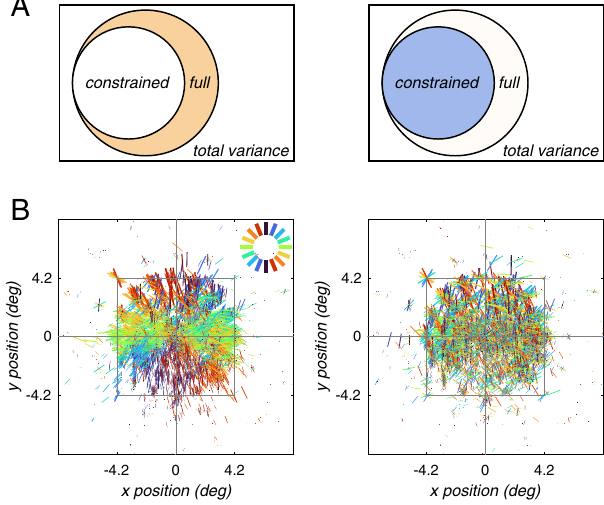
Fig. 6 | Control analyses demonstrate that the full model indeed captures orientation selectivity that cannot be derived from the constrained model. A Schematic Venn diagram illustrating the control analyses. First, the constrained model was fi t. The full model was then fi t either to the residual (left) or the output (right) of the constrained model. B Orientation map in visual space derived from the two analyses. Same format as Fig. 3A. The orientation map on the left is nearly identical to the map estimated from the original data (see Fig. 3A), indicating that the full model capitalizes on variance not modeled by the constrained model. In contrast, the orientation map on the right has no discernable organization, demonstrating that the constrained model cannot explain variance re fl ecting orientation